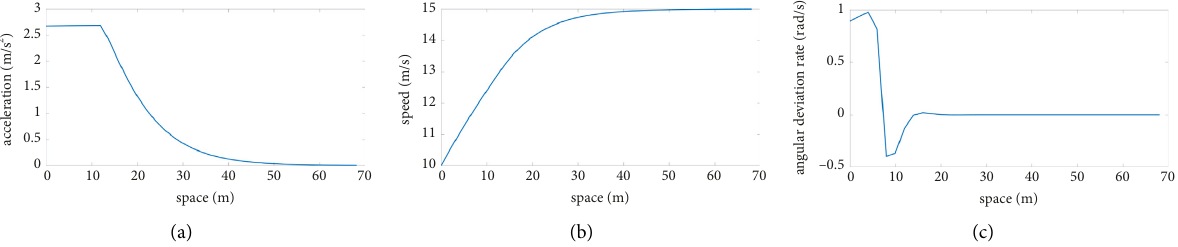
Figure 6: Speed, acceleration, and angular deviation rate of CAV without the “buffer zone”: (a) acceleration; (b) speed; (c) angular deviation rate.